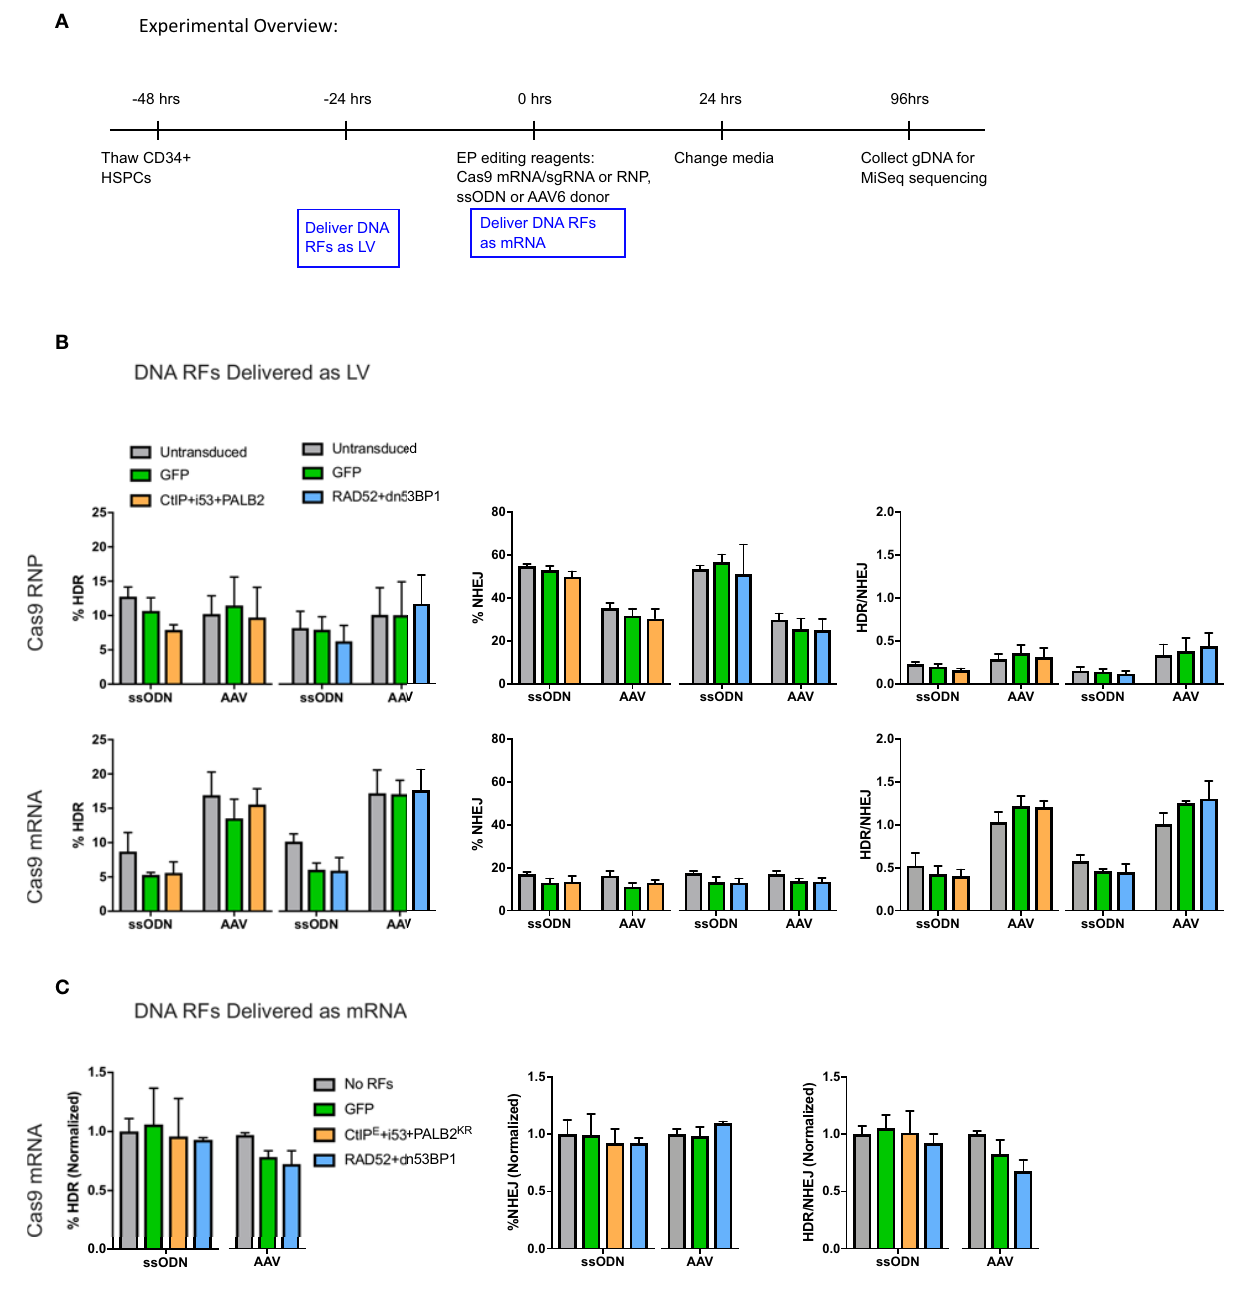
FIGURE 2 | (A) Experimental overview of CD34 + HSPC transduction and electroporation of DNA RFs and editing reagents. DNA RFs were co-expressed with the gene editing reagents. Cas9 nuclease was delivered either as RNP (100 pmol Cas9 protein + 4.5 µ g of IVT sgRNA) or IVT Cas9 mRNA (5 µ g) + IVT sgRNA (5 µ g); donor template was delivered either as AAV6 (MOI 2e4) or ssODN (3 µ g). HDR and NHEJ levels were measured by HTS four days post-electroporation. HDR/NHEJ ratio was calculated. (B) DNA repair factors delivered as LV 24h prior to electroporation of editing reagents. n = 4 biological replicates for all CtIPDE+PALB2KR+i53 LV experiments (Cas9 RNP or Cas9mRNA); n = 8–12 for RAD52 + dn53BP1 LV experiments using Cas9 RNP, or n = 4 for RAD52 + dn53BP1 LV experiments using Cas9 mRNA. Error bars, mean ± SD. Differences are not significant if not specified, based on Wilcoxon rank sum test. (C) DNA RFs were co-delivered as IVT mRNA with editing reagents. n = 2–6 biological replicates for all conditions. Data are normalized to “no RFs” conditions for each set of experiments. Error bars, mean ± SD. Differences are not significant if not specified, based on Wilcoxon rank sum test.